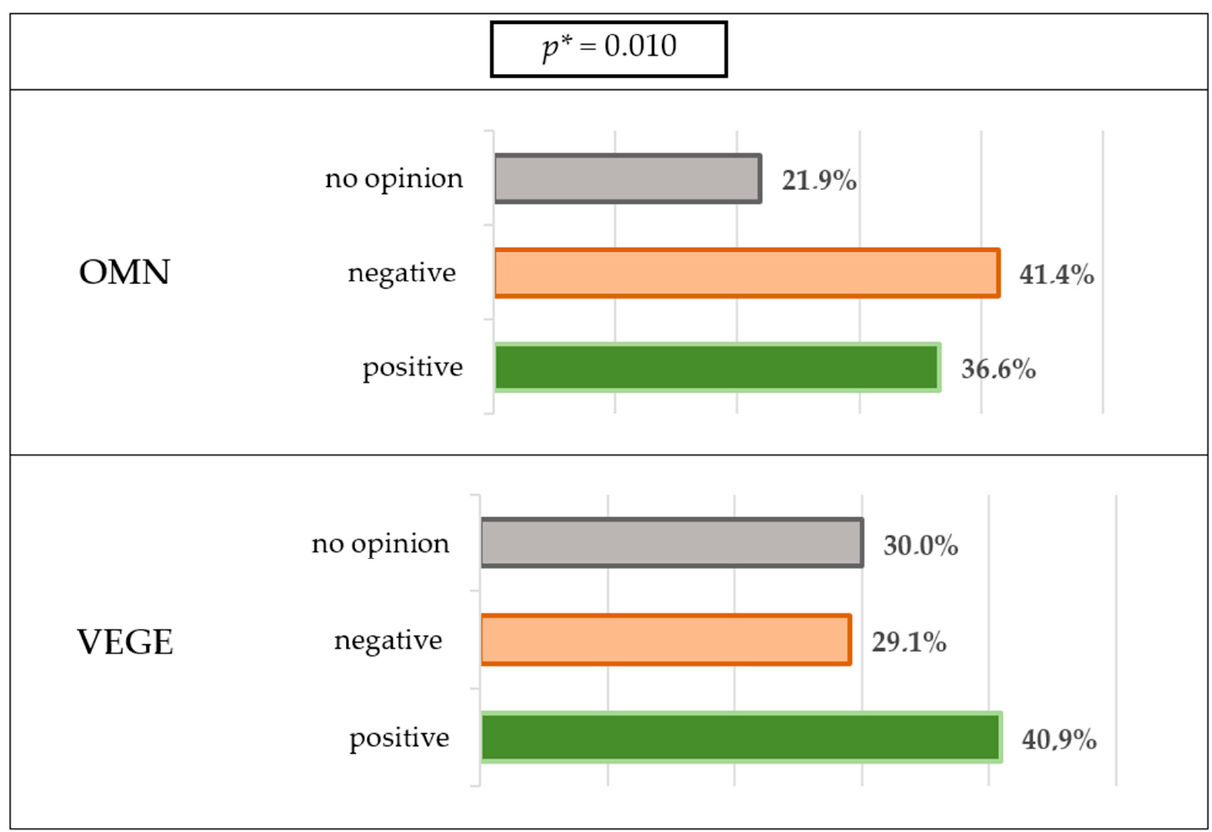
Figure 5. Dietary changes during the lockdown. * p —calculated between the studied groups using χ ²